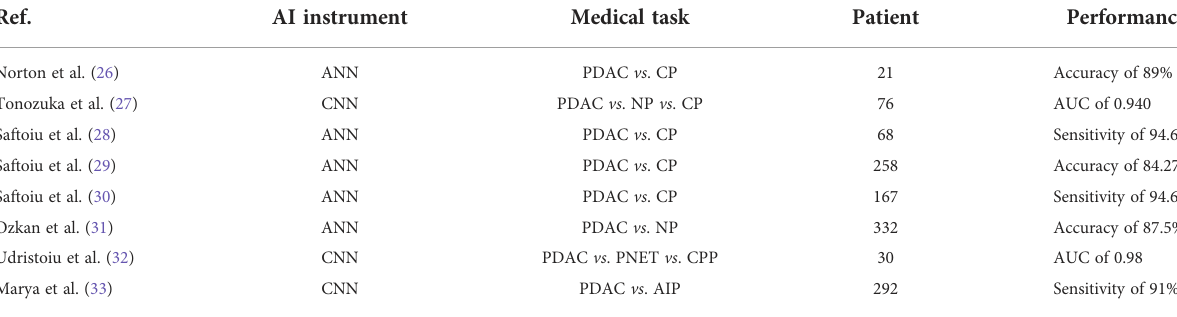
TABLE 4 Diagnosis of pancreatic cancer by endoscopic ultrasonography.